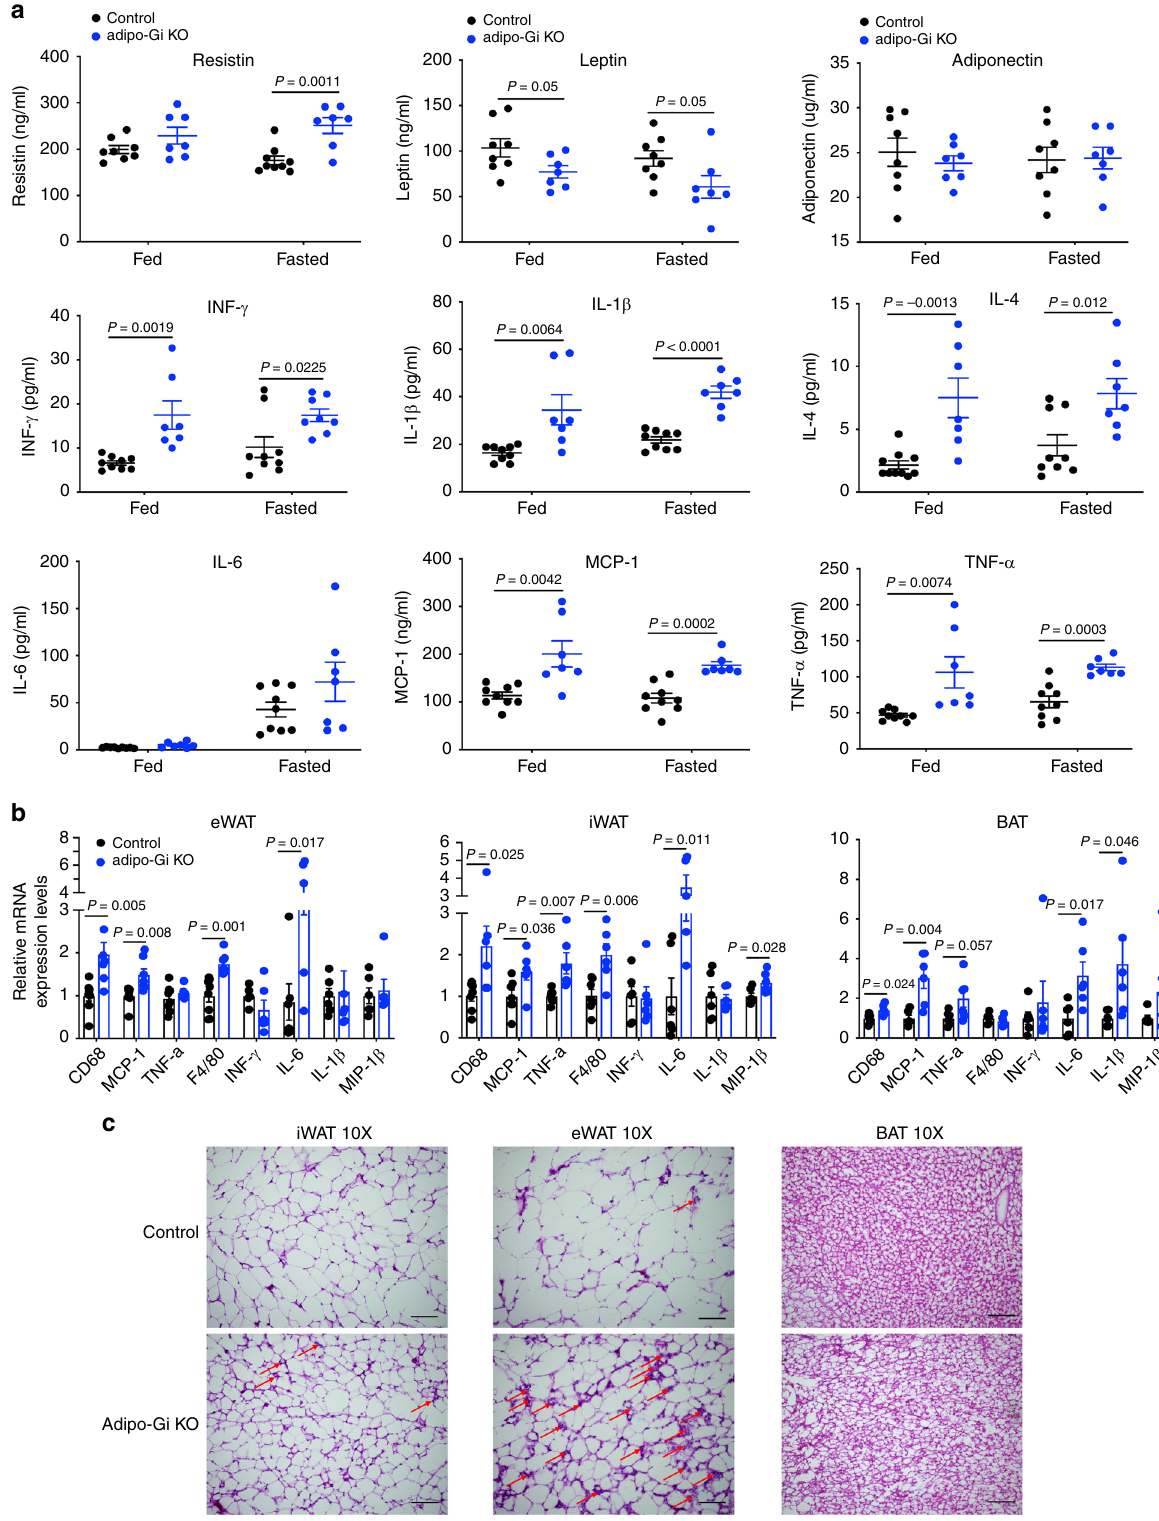
Fig. 5 Plasma in fl ammatory cytokines and adipose tissue in fl ammation markers are increased in HFD adipo-Gi KO mice. a Plasma adipokine and cytokine levels of adipo-G i KO and control mice (males) after 8 weeks of HFD feeding (control, n = 9; adipo-Gi KO, n = 7). Interferon- γ , INF- γ ; interleukin-1 β , IL-1 β ; interleukin-6, IL-6; interleukin-4, IL-4; monocyte chemoattractant protein-1, MCP-1; tumor necrosis factor α , TNF- α . b Relative mRNA expression levels of adipose tissue genes related to in fl ammation ( n = 6 per group). c Representative Hematoxylin & Eosin (H&E) staining of sections of inguinal white adipose tissue (iWAT), epididymal WAT (eWAT), and brown adipose tissue (BAT) from mice maintained on a HFD for 12 weeks ( n = 6 per group; scale bars = 200 μ m). Representative mononuclear in fl ammatory cells are highlighted by red arrows. Data are given as means ± s.e.m. P values are indicated in the different panels ( a , b : two-tailed Student ’ s t test). Source data are provided as a Source data fi